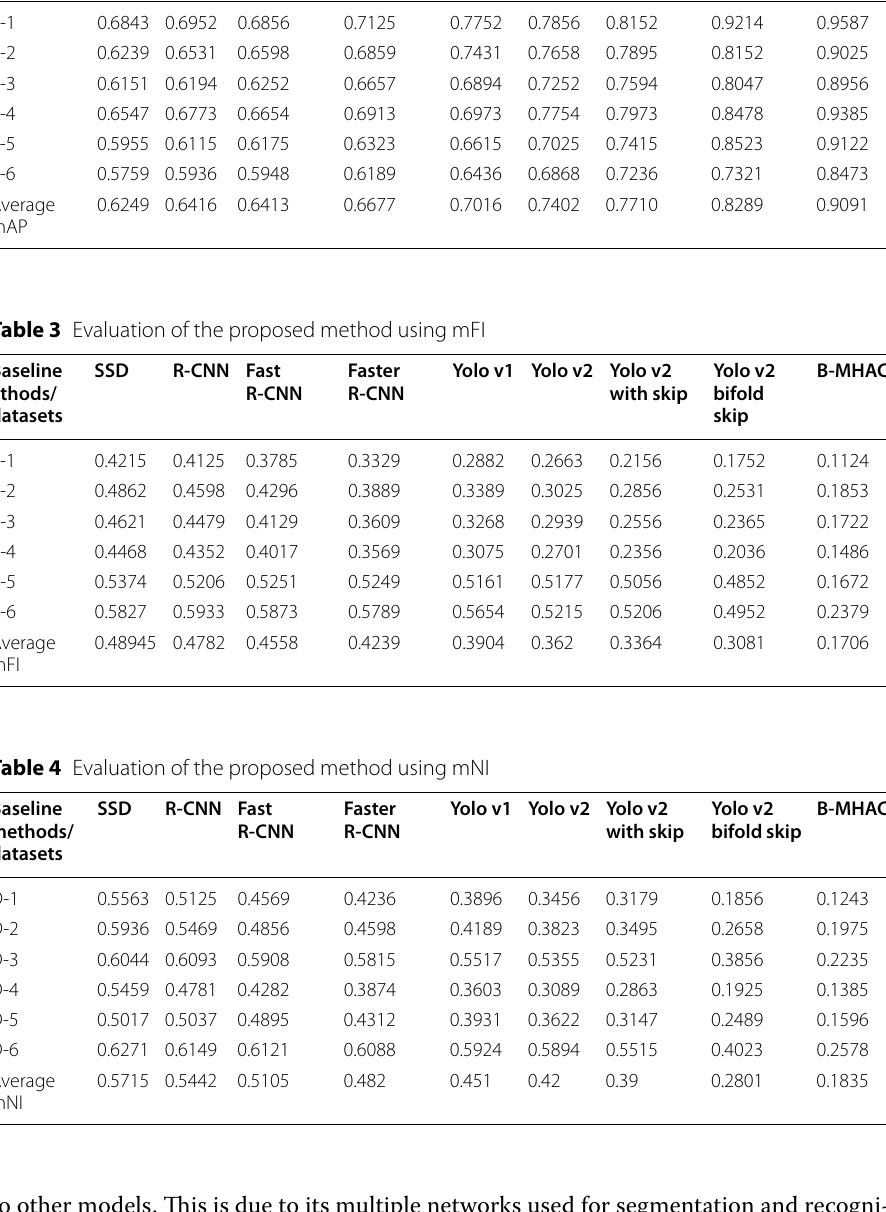
Table 2 Evaluation of B-MHAC against state-of-the-art methods on perfromance parameter mAP Baseline methods/